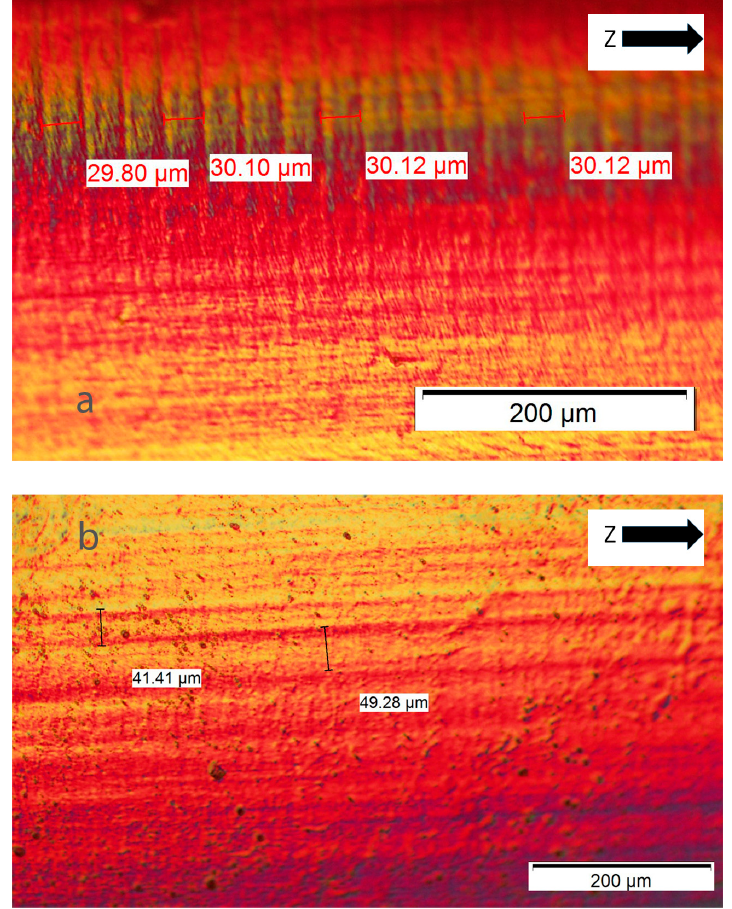
Figure 7. Castable Blend. Fracture section of edge sample. ( a ) Layer thickness; ( b ) Vertical lines due to columns of pixels.